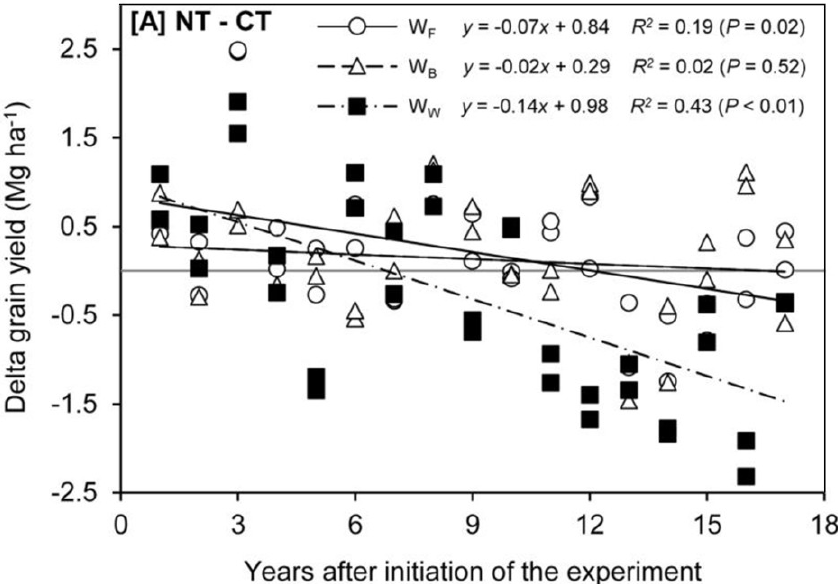
Figure 2. In a field experiment running for 17 years, Amato et al. [180] found that crop rotations and the occurrence of dry years (e.g., Year 3) had a major impact on grain yield differences (termed Delta grain yield below) between no-till (NT) and conventional tillage (CT). Continuous wheat (WW) followed a general trend of decreasing grain yield over time under NT soil tillage, whereas berseem clover–wheat (WB) and faba bean–wheat (WF) crop sequences were less affected by a conversion from CT to NT. Reprinted with permission from Amato et al.